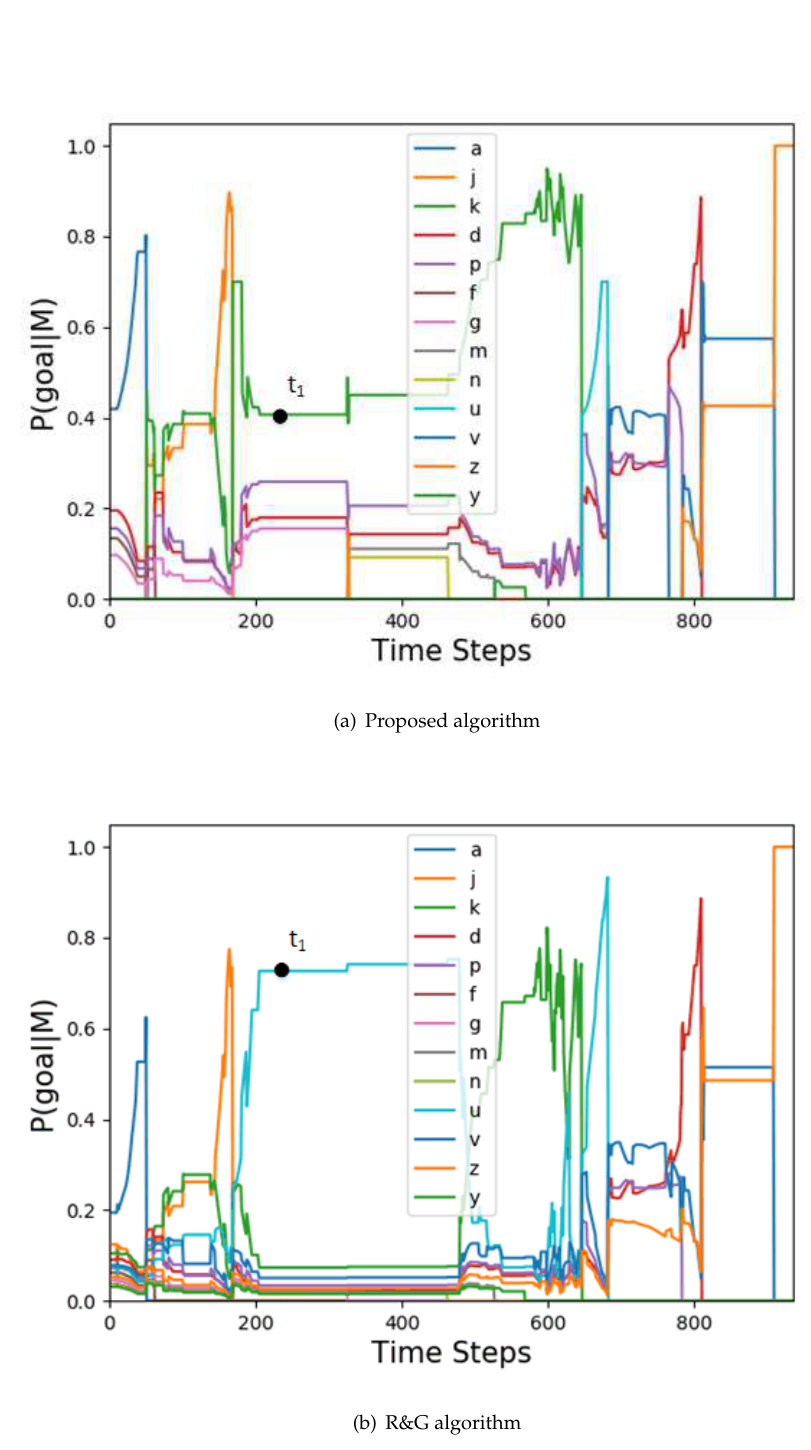
Figure 4. The goal probability curves of agent